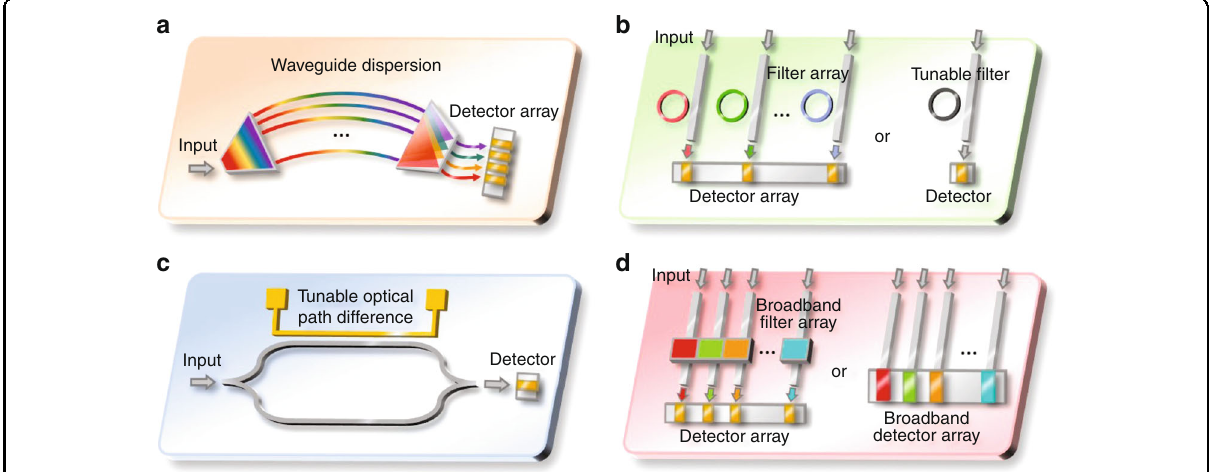
Fig. 6 Working principles of on-chip spectrometers. Schematic illustration of the underlying principles for different on-chip integrated spectrometers, including WdM spectrometers based on ( a ) dispersive structure, ( b ) arrayed or tunable narrowband fi lters, and WM spectrometers based on ( c ) Fourier-transform spectrometers formed by tunable Mach – Zehnder interferometers, and ( d ) broadband fi lter or detector arrays with distinctive spectral responses for computational spectrum reconstruction,